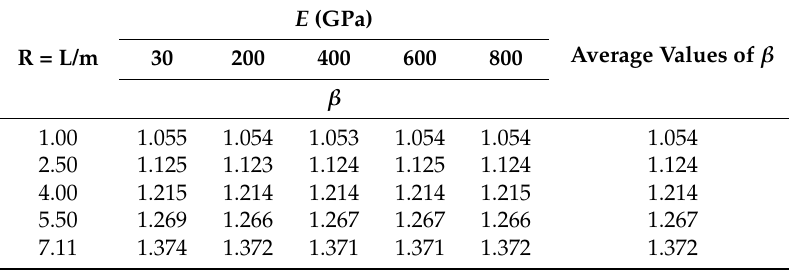
Table 4. Values obtained for the correction factor β in the numerical simulations with flat indenters. E R = L/m